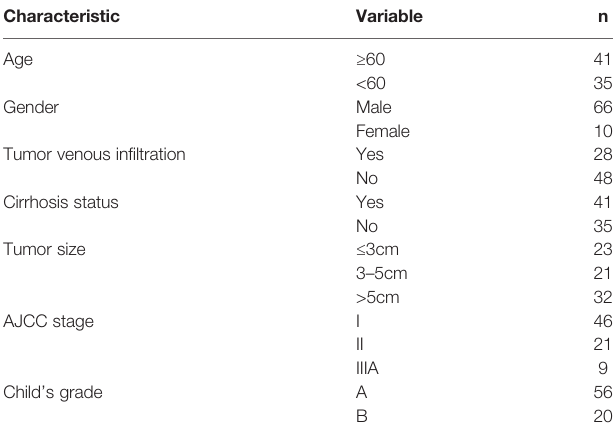
TABLE 1 | Clinical features of the Singapore HCC